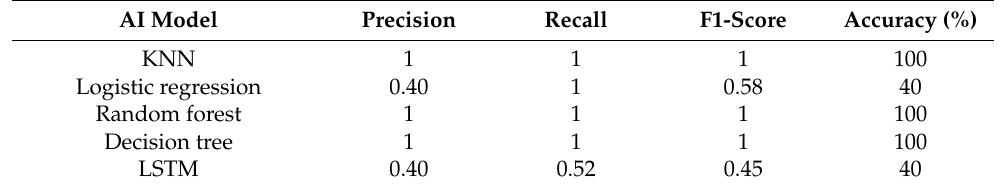
Table 2. Accuracy comparison among the AI models during jamming and spoofing attack